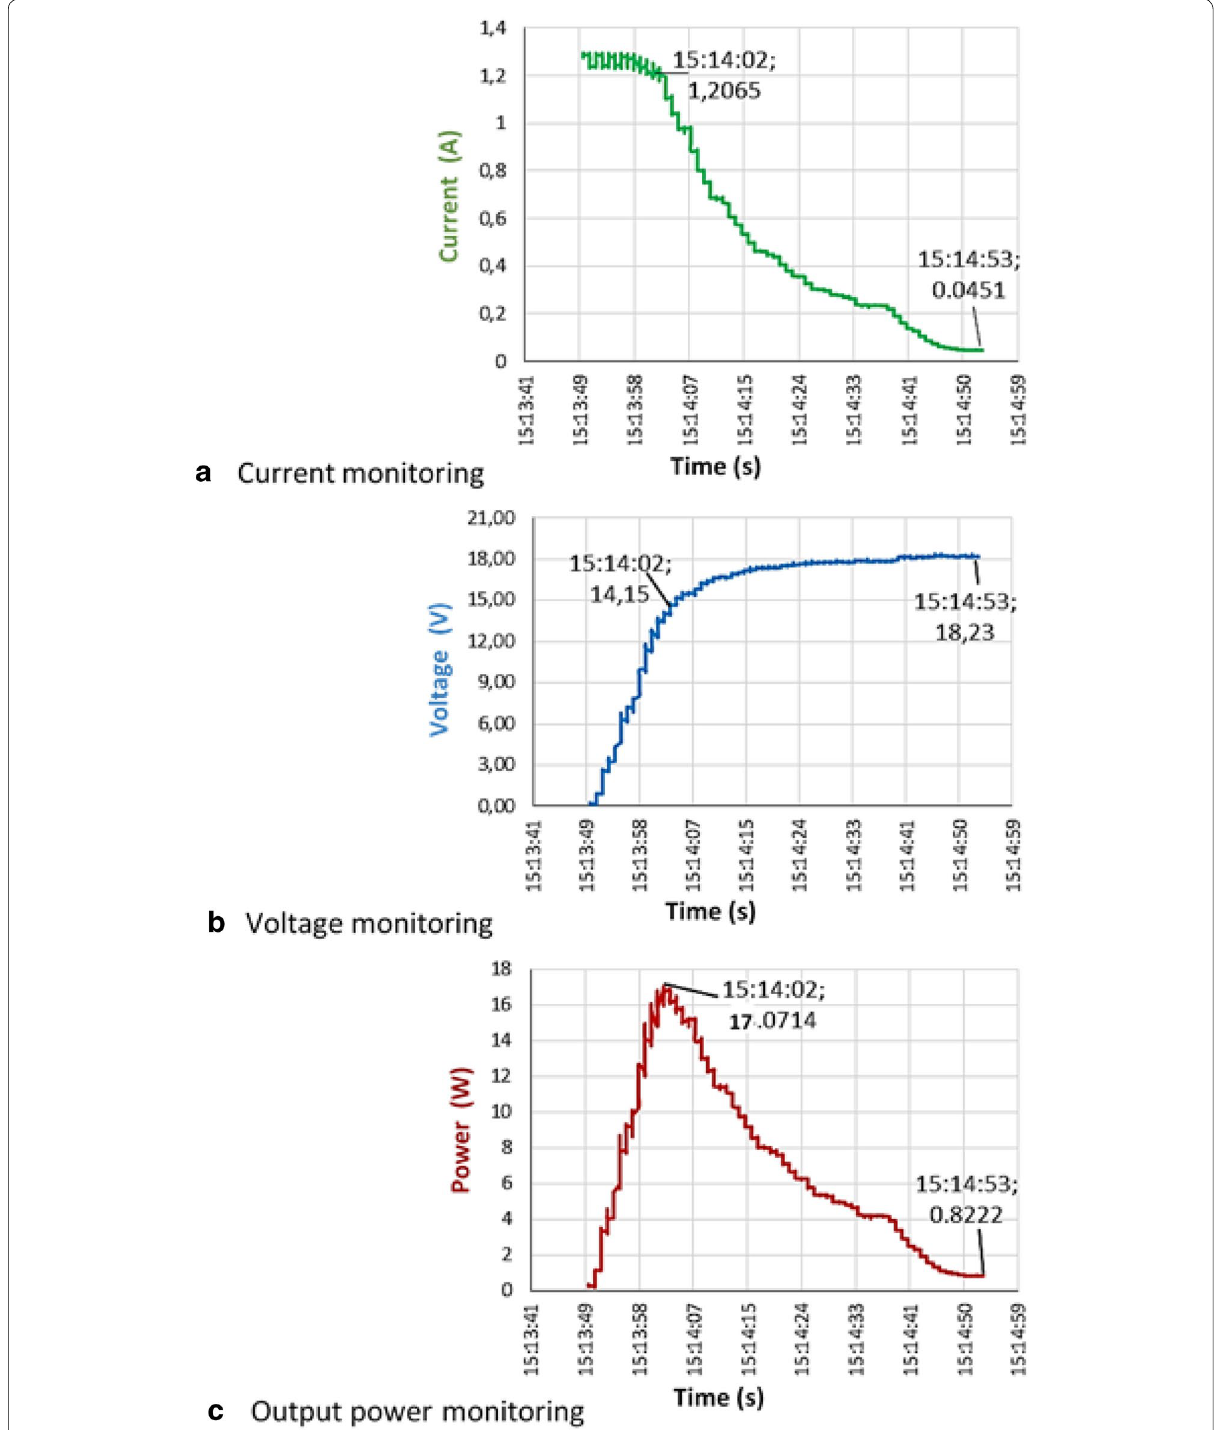
Fig. 20 Monitoring of PV panel output characteristics: a current monitoring curve, b voltage monitoring curve, c output power monitoring curve (at T 75 °C and G 1100 W/m 2 = =